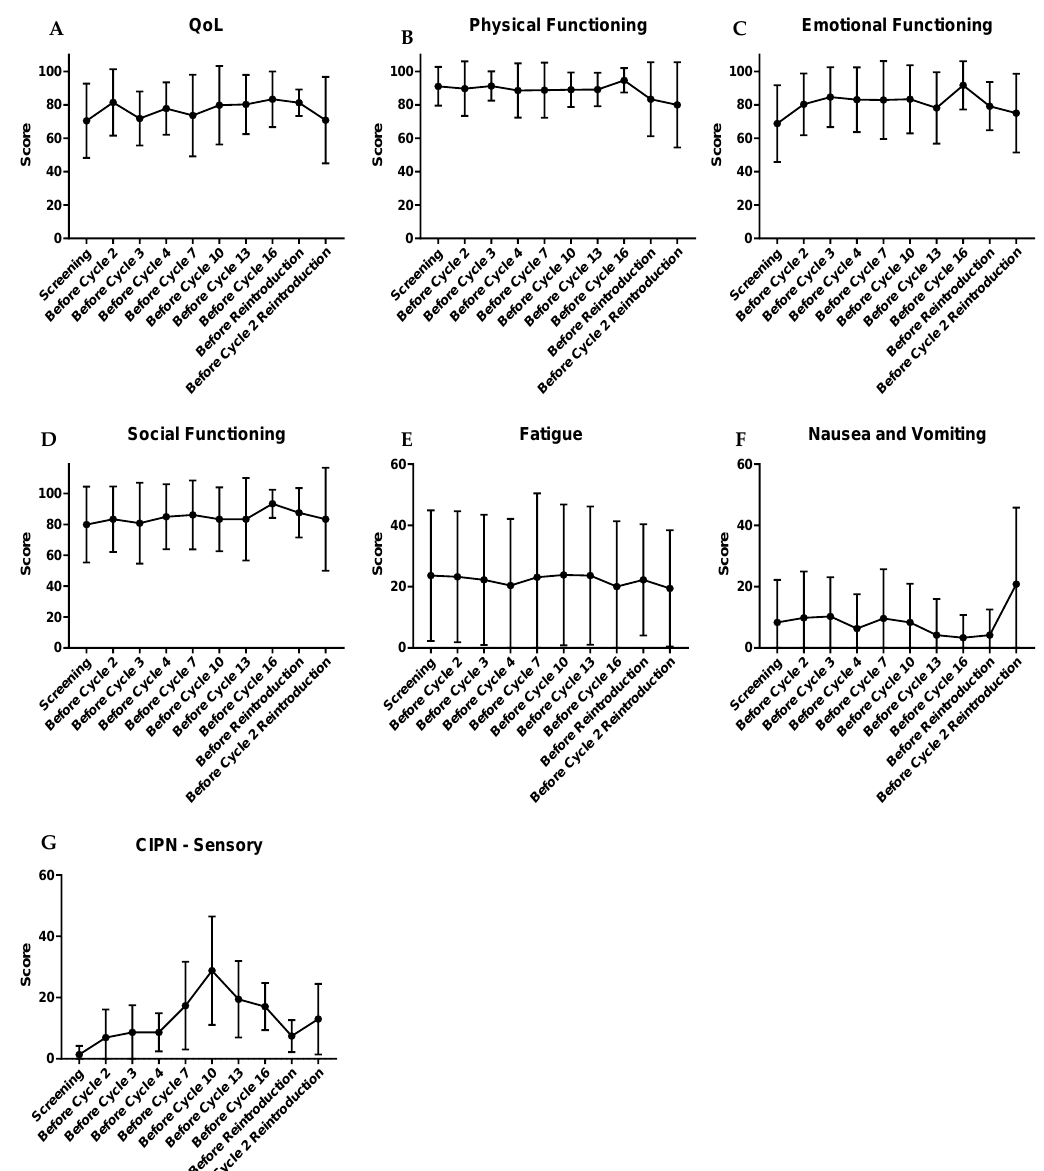
Figure 4. Health related quality of life and neurotoxicity. Domains and single items range from 0 to 100 with high function scores denoting high level of functioning and high symptom scores denoting a high level of symptoms. CIPN: Chemotherapy Induced Peripheral Neuropathy.